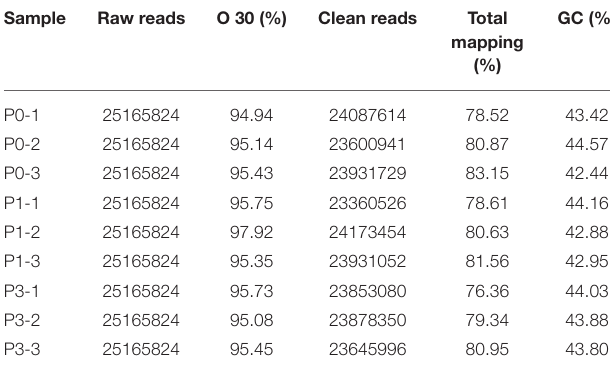
TABLE 2 | Overview of miRNA sequencing data. P0, P1, and P3 in the table represent the groups 0 dpi, 1 dpi, and 3 dpi.